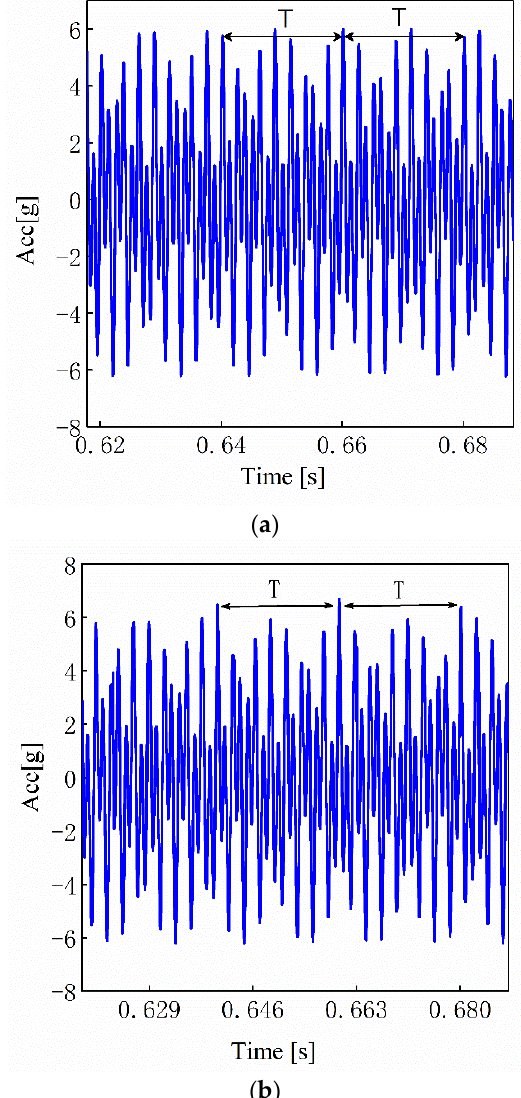
Figure 16. Vibration acceleration under cracked state. ( a ) Before improved. ( b ) After improved. The acceleration of the gear on the output shaft of the two-stage gears under the healthy and the faulty state is analyzed in Figure 17. Fourier transform is applied to the vibration acceleration of the driven gear 4 in x direction in time domain. The influence of the crack fault is small on the second gear of the output shaft. The acceleration vibration amplitude of the driven gear of the second-stage at the mesh frequency is reduced only approximately 0.08 g. There is nearly no sidebands around the mesh frequency and its